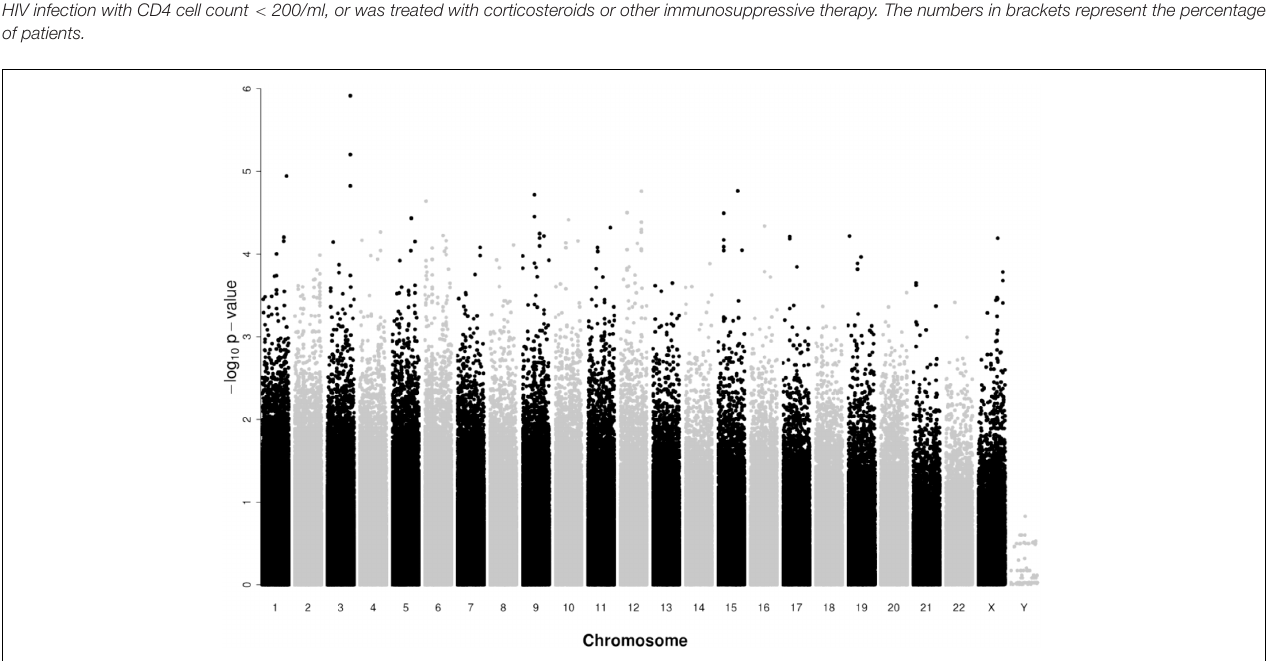
FIGURE 2 | Manhattan plot of genome-wide association results for the discovery VIRSTA cohort. The x -axis represents the chromosome number and the y -axis shows the P -values in – log10 scale. Dot represent SNP. A total of 67 cases and 72 controls are compared. 631,710 SNPs that passed all quality control filters